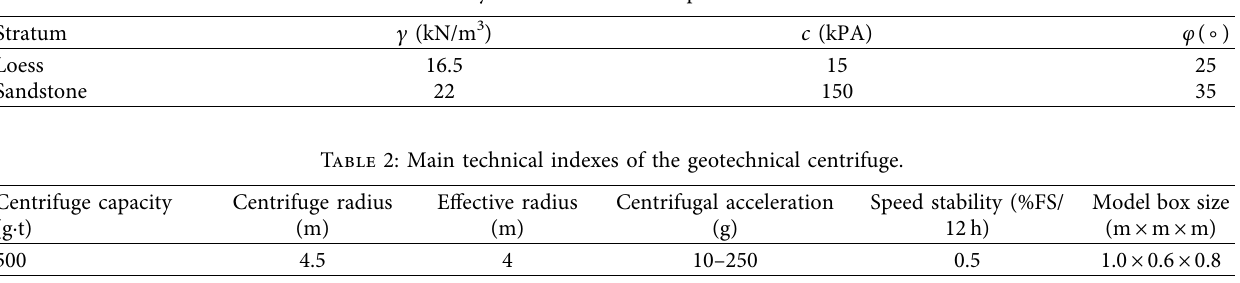
Figure 1: Prototype of the three-stage loess slope supported by the frame structure with anchors. Table 1: Physical and mechanical parameters of soil.